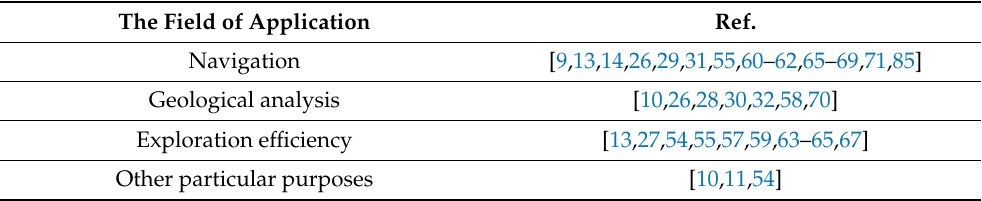
Table 7. The classification of the field of application in the Included Study